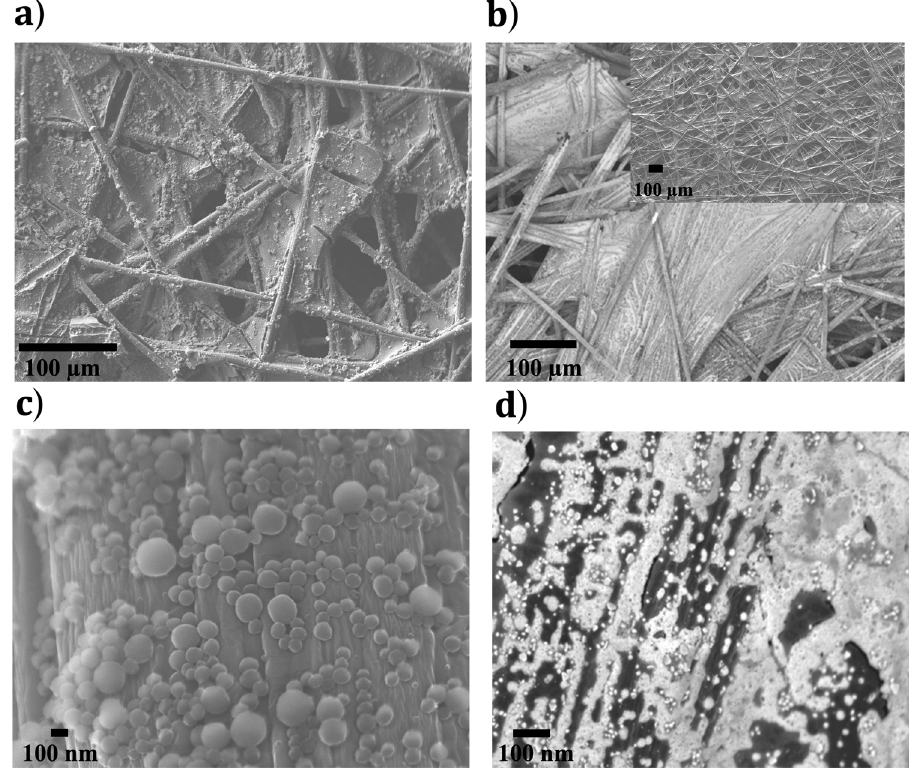
Fig. 3 SEM images of quinone-based species on TCP. Top view of ( a ) sepia, ( b ) silver-stained catechin on TCP while ( c ) and ( d ) are tilted, zoomed-in views of samples in ( a ) and ( b ) at 5 keV. Inset (Fig. 4b) is the top-view image of unstained catechin on